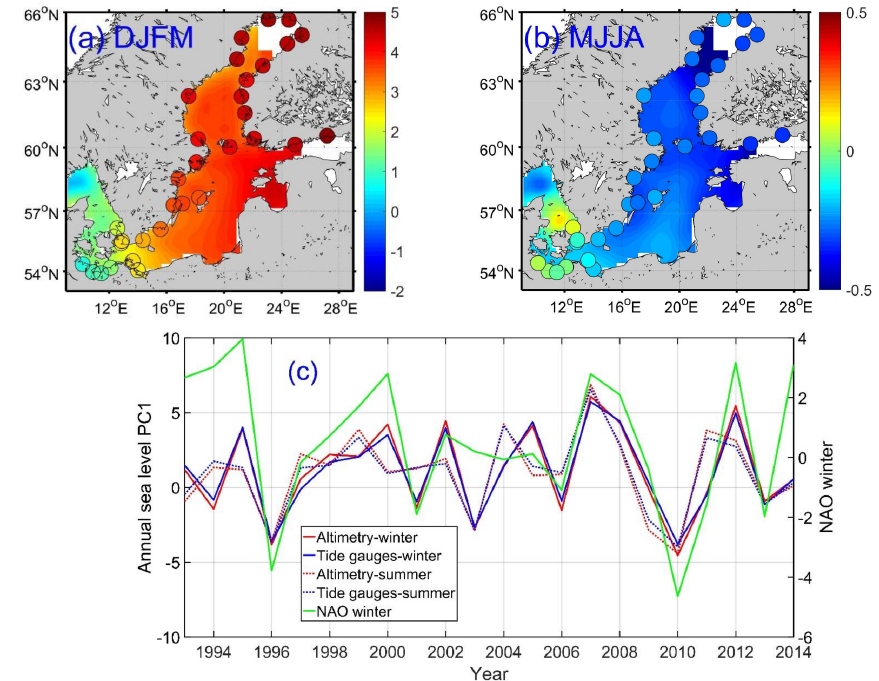
Figure 8. Average of ( a ) winter (December–March) and ( b ) summer (May–August) CSEOF first model LVs (cm) calculated from satellite altimetry and tide gauge data. ( c ) Average of winter and summer CSEOF first mode PC time series (dimensionless). The station-based winter NAO index (December–March) is